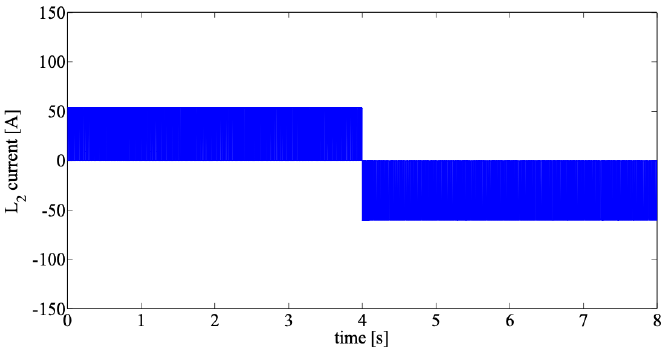
Figure 18. Dynamic behavior of the L 2 current (case B).